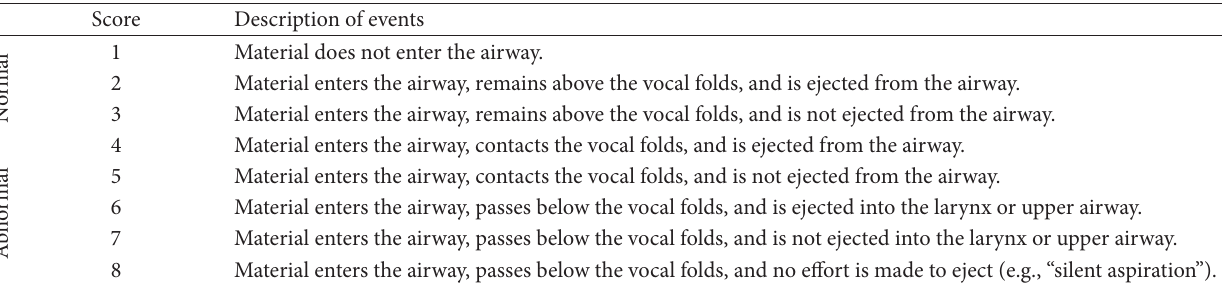
Table 1: The 8-point Penetration Aspiration Scale [8].